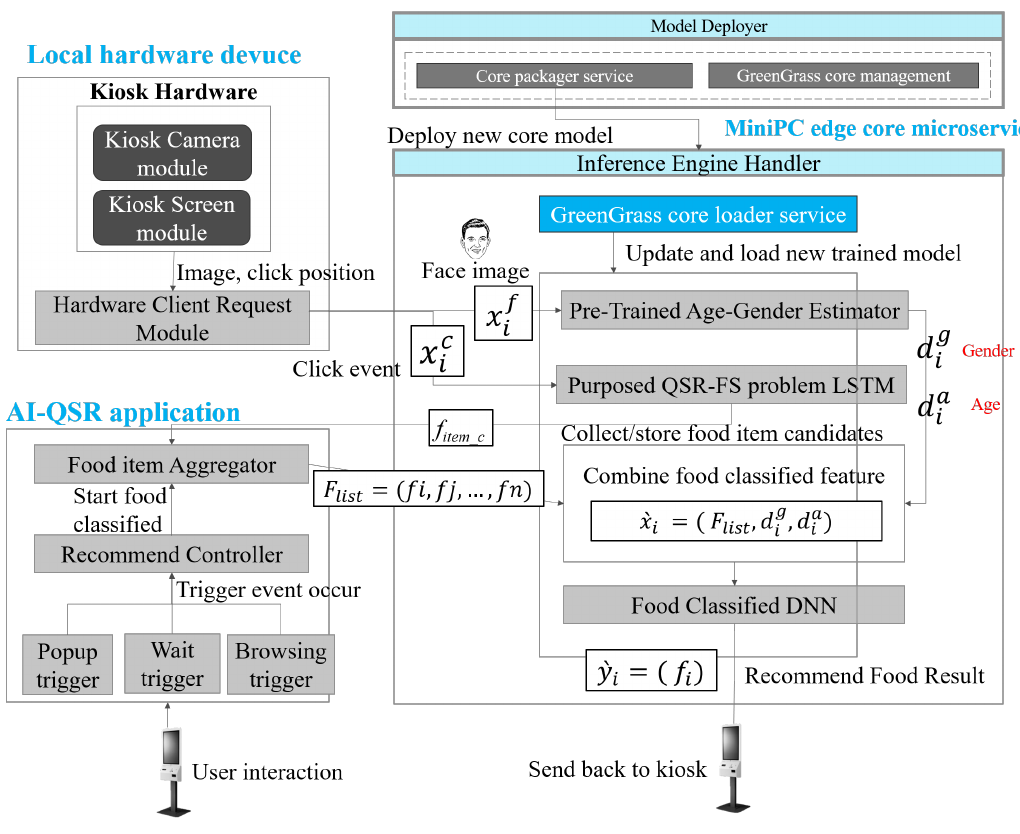
Figure 11. The AI-QSR recommendation